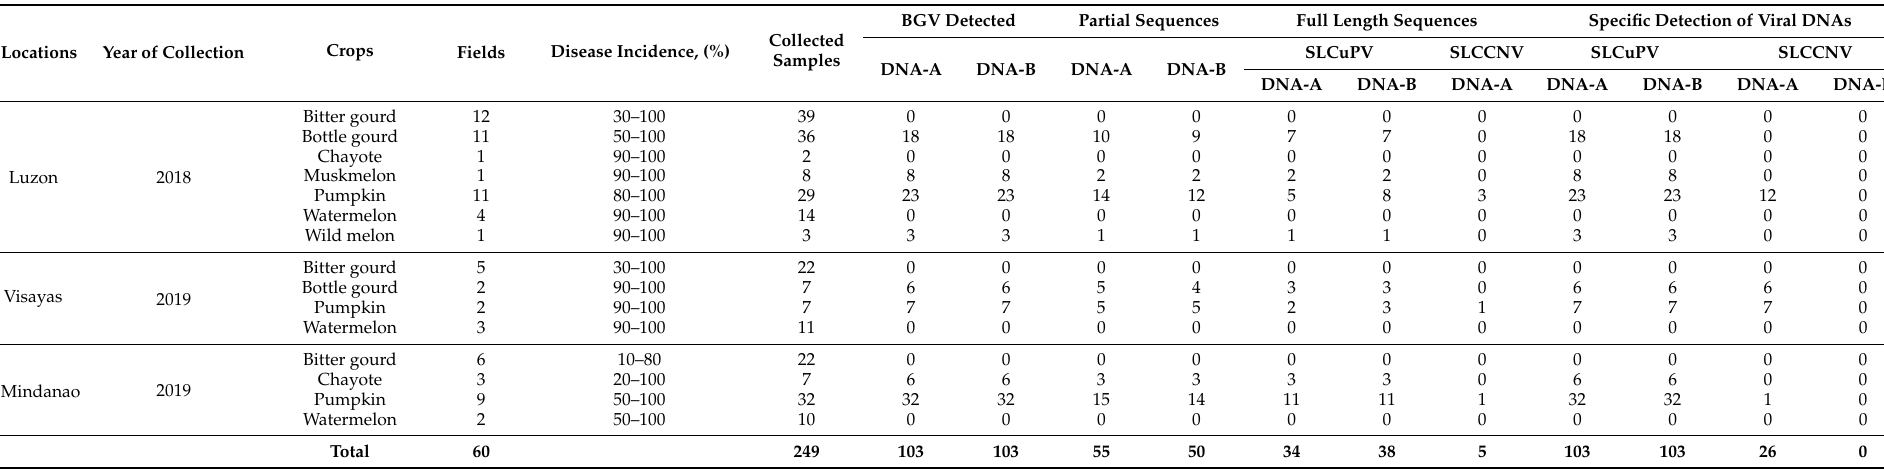
Table 1. Begomovirus detection of cucurbit samples collected in the